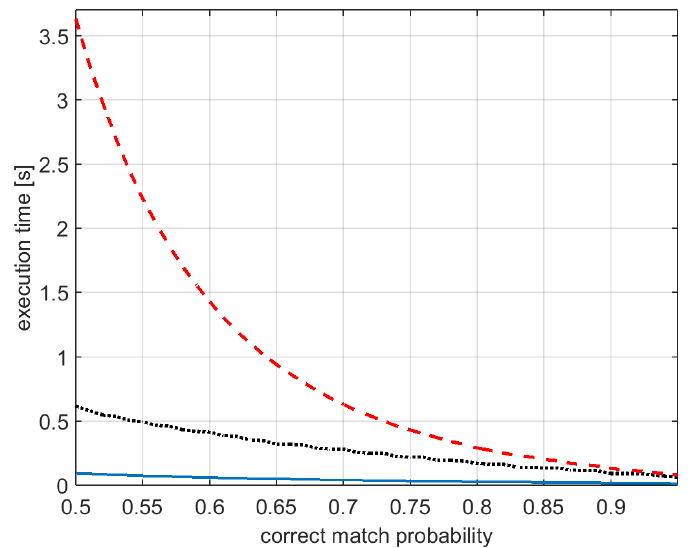
Figure 11. Computational time for obtaining estimates of the essential matrix varying β . Comparison of the results obtained with the standard five-point algorithm ( red dashed line), Algorithm 1 of Section 3.1 ( blue solid line), and the two-step algorithm (Algorithm 2) of Section 3.2 ( black dotted line).